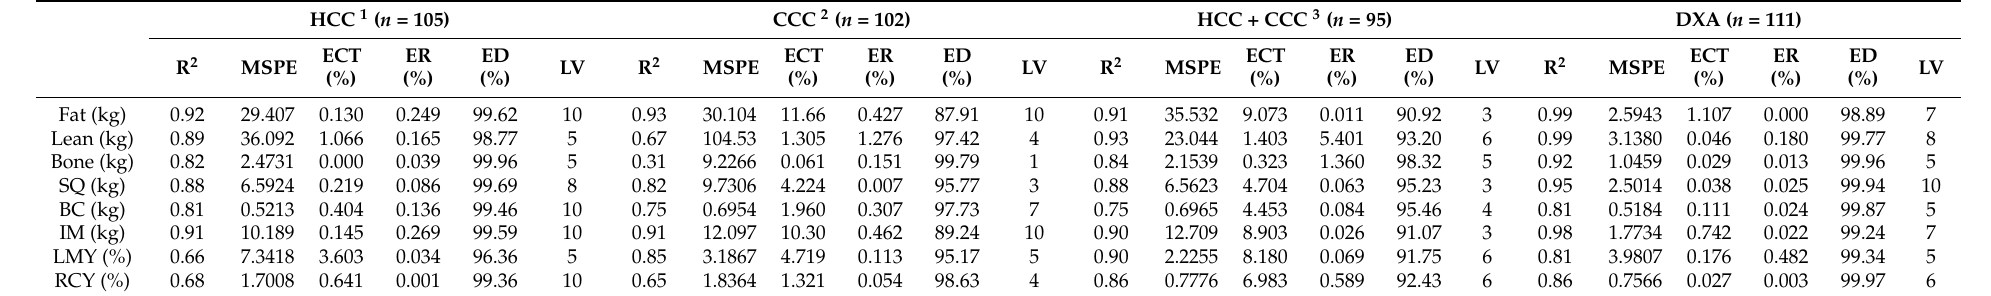
Table 4. Partial least square regression models estimating total fat, lean, and bone amounts, and total subcutaneous (SQ), body cavity (BC), and intermuscular (IM) fat amounts for whole carcass sides and total lean meat yield (LMY) and retail cut yield (RCY) from dual-energy X-ray absorptiometry (DXA) and computer vision system (CVS) values. Coefficient of determination (R 2 ), mean square prediction error (MSPE), error in central tendency (ECT), error due to regression (ER), error due to disturbances (ED), and the number of latent variables (LV) are presented for each